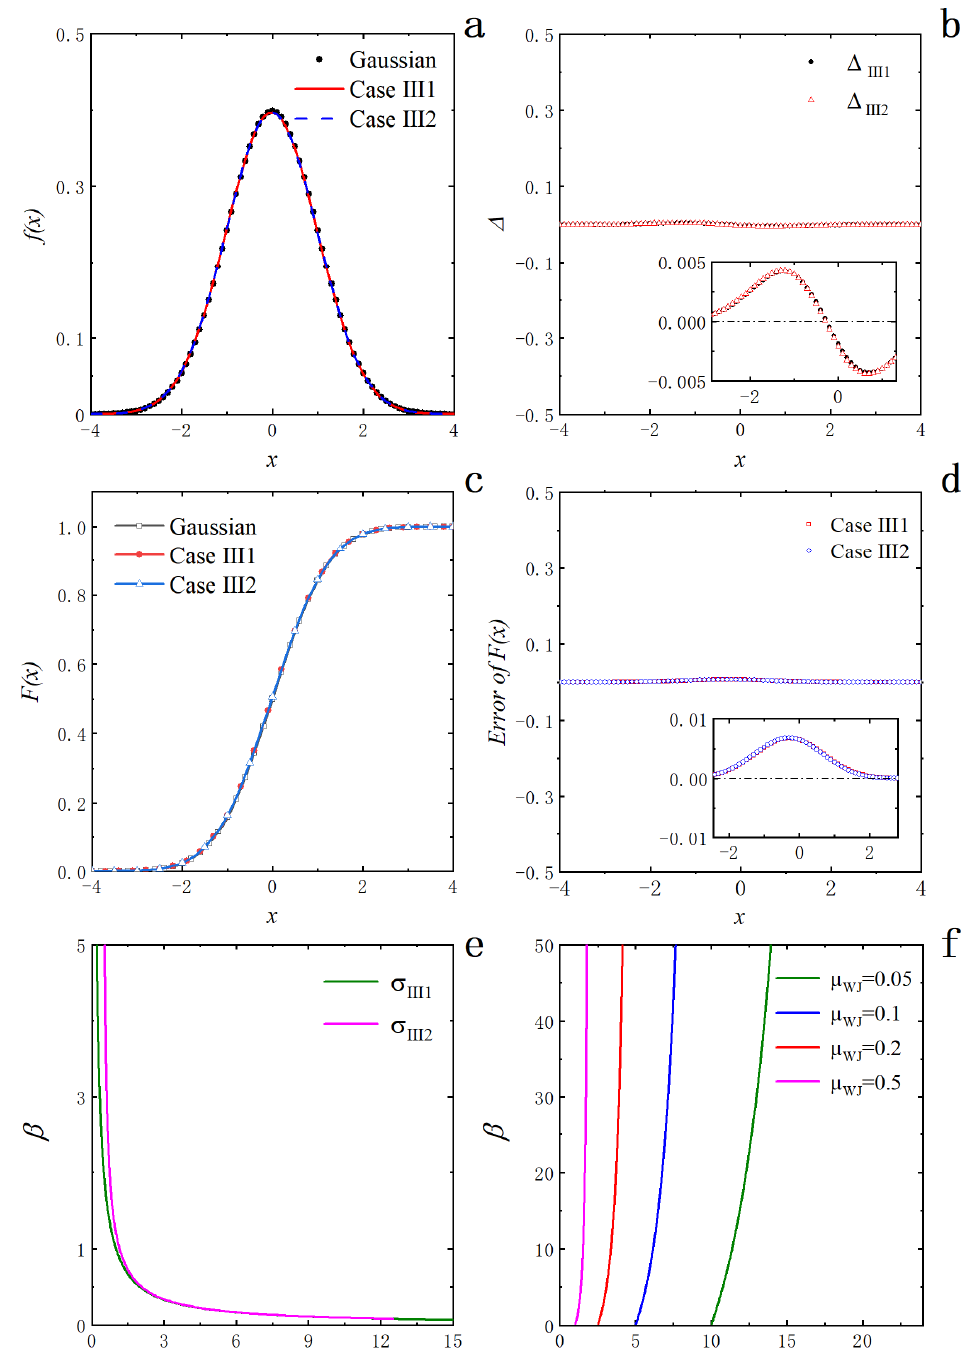
Figure 6. Analyses of expanding the WJ function by Method III performed at the mode x = x m . ( a ) Gaussian, Case III1 and Case III2 for the standard normal distribution, N ( ˆ µ III , ˆ σ III1 ) and N ( ˆ µ III , ˆ σ III2 ) , correspondingly; ( b ) ∆ III1 and ∆ III2 for the residual scatters of N ( ˆ µ III , ˆ σ III1 ) and N ( ˆ µ III , ˆ σ III2 ) versus N ( 0, 1 ) , respectively; ( c ) Gaussian, CaseIII1 and CaseIII2 for the cumulative probability distribution functions of N ( 0, 1 ) , N ( ˆ µ III , ˆ σ III1 ) and N ( ˆ µ III , ˆ σ III2 ) , separately; ( d ) CaseIII1 and CaseIII2 for the respective residual plots of the cumulative probability distribution functions of N ( ˆ µ III , ˆ σ III1 ) and N ( ˆ µ III , ˆ σ III2 ) relative to N ( 0, 1 ) ; ( e ) σ III1 and σ III2 for relationship between α and β when ˆ σ III1 = 1 and ˆ σ III2 = 1, respectively; ( f ) Relationship between α and β assuming ˆ µ III = 0 with µ WJ ∈ ( 0.05, 0.1, 0.2,0.5 ) according to Equation (27),